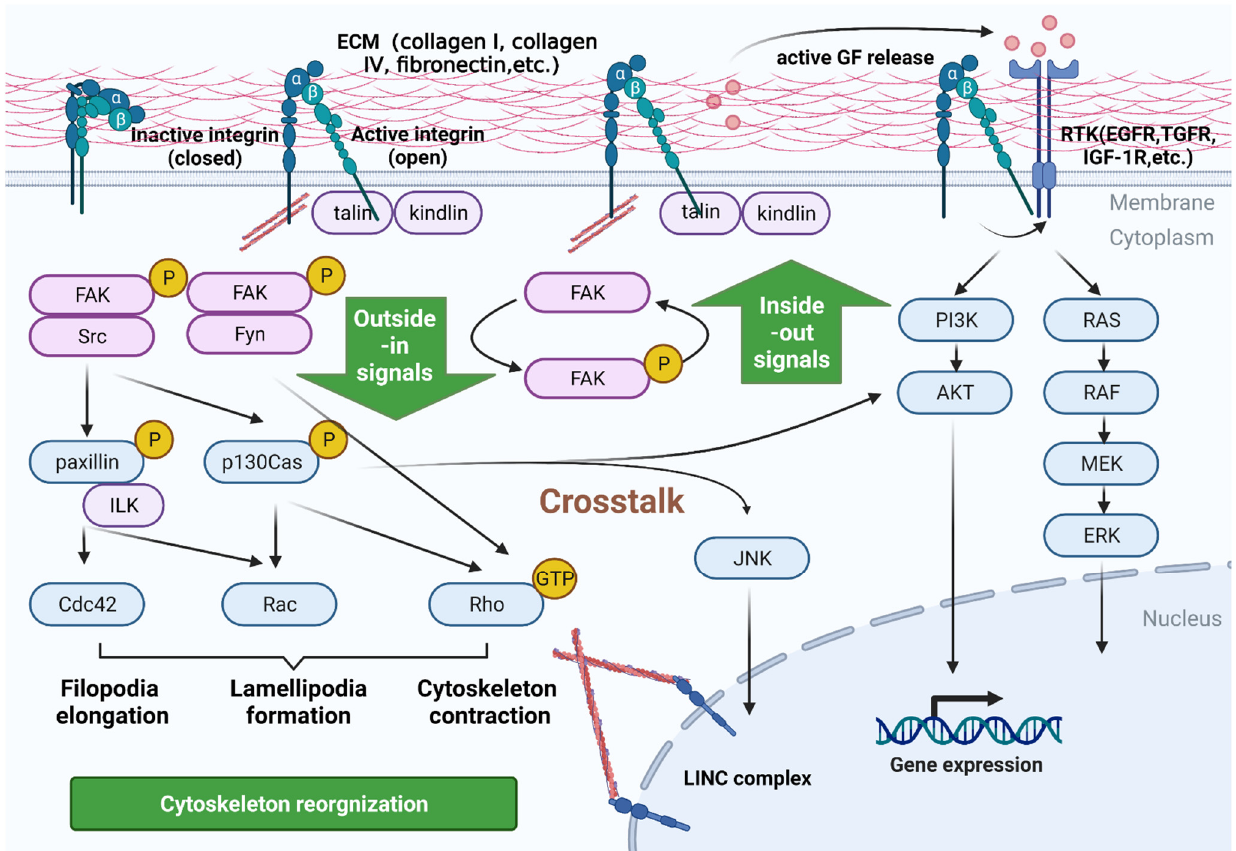
Figure 1. Signaling pathways mediated by integrins in PC cells. Integrins are heterodimeric cell- surface proteins consisting of α and β subunits. They have both inactive and active conformations that determine their binding affinities for ECM ligands (e.g., collagen I, collagen IV, fibronectin). Inactive integrins are always bent with physiological low-affinity, whereas active integrins are in an extended state with high-affinity and exhibit the separation of α and β lower legs. Active integrins recruit the adapter talins and, subsequently, activate FAK and Src. FAK/Src complex recruits and phosphorylates p130Cas and paxillin, and then induces the activation of downstream signaling, including Rac, Cdc42, and Rho, which are crucial regulators of cytoskeletal reorganization. This process can transmit information on their ligands’ chemical identity and physical state into cells, called the outside-in signals. Integrin adhesion can also crosstalk with other RTK pathways to regulate cell migration, survival, and growth. Additionally, integrins respond to inside-out signals by regulating protein interactions at the cytoplasmic tail region of integrins and modulating the strength of cell